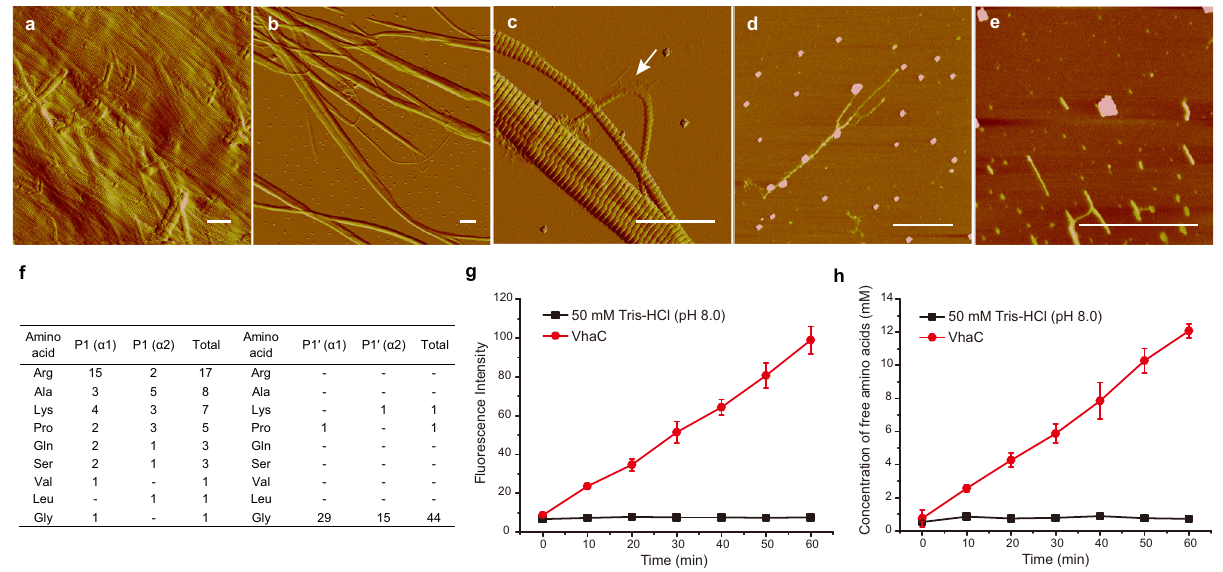
Fig. 5 Degradation pattern of VhaC on type I collagen fi bers. AFM observation of collagen fi bers degradation by VhaC. Collagen fi bers were treated with 50 mM Tris-HCl (pH 8.0) ( a ) or 0.1 μ M VhaC ( b – e ) at 30 °C for 5 h with continuous stirring and then observed by AFM. Tight collagen fi bers were cut into fi